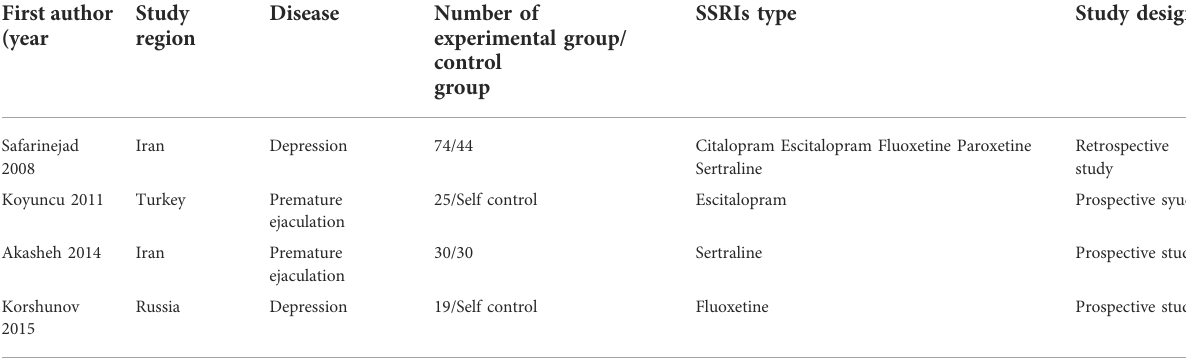
TABLE 1 Basic characteristic of the included